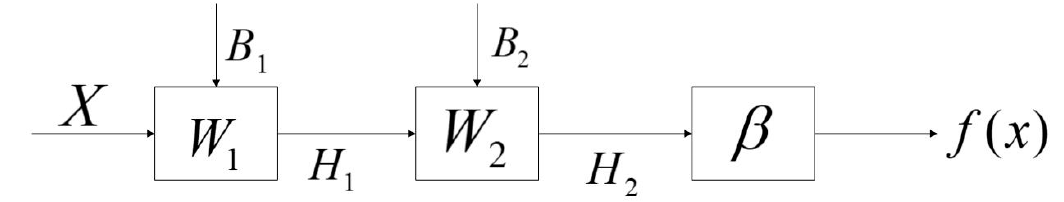
Figure 5. Network structure of VTELM.